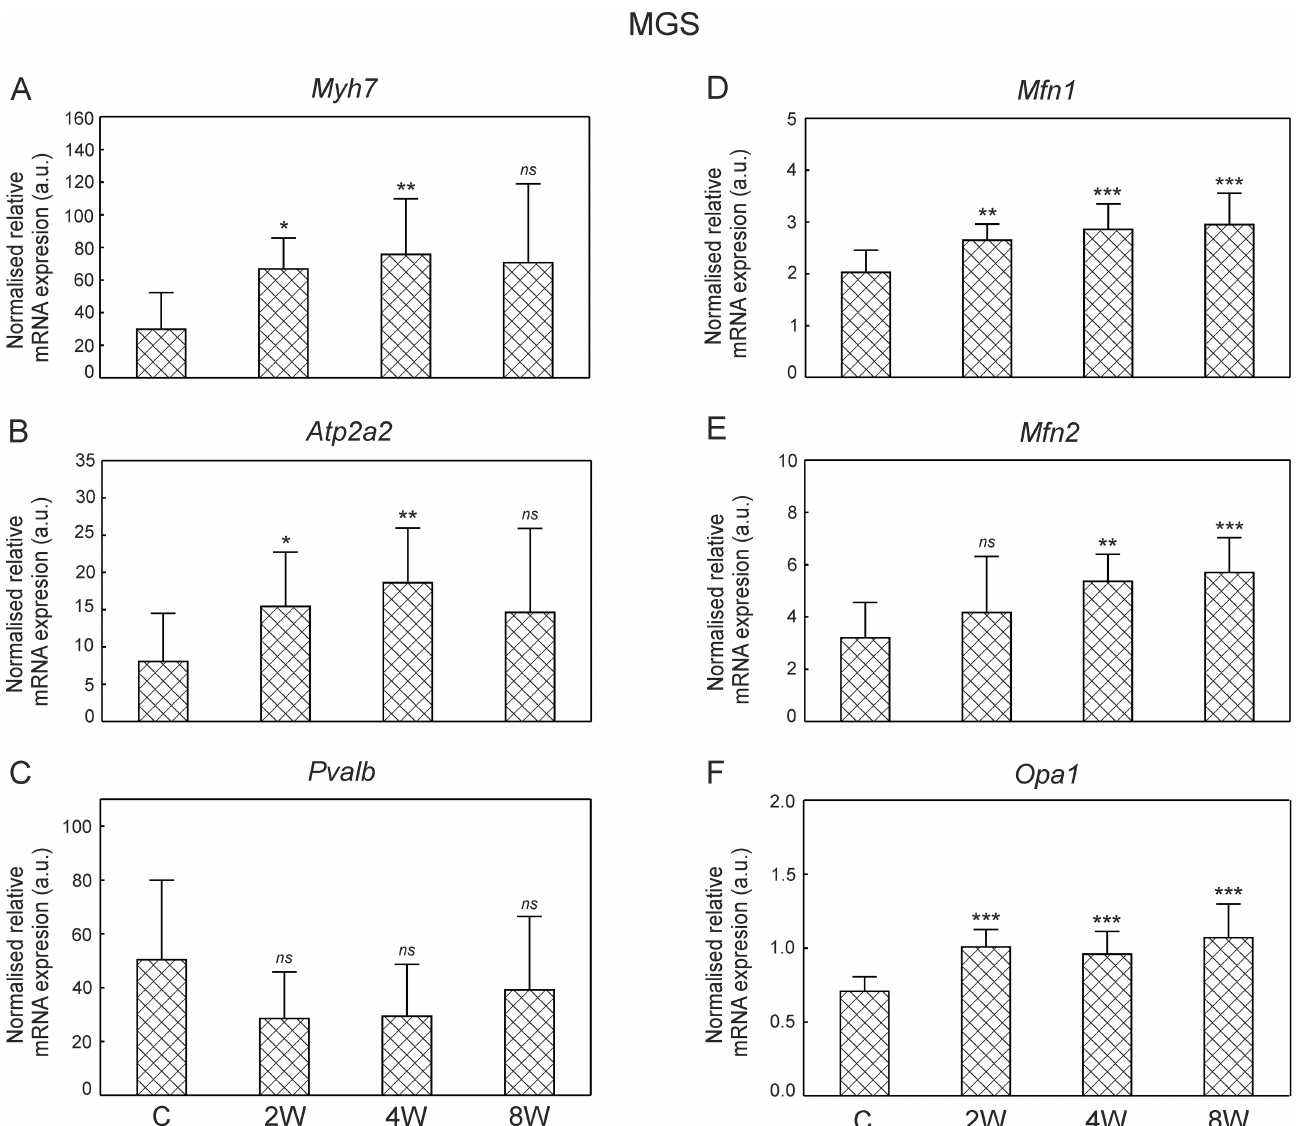
Fig 6. Relative mRNA expression levels in the MGS in control and trained animals. Relative mRNA expression of myosin heavy chain slow isoform ( Myh7 , panel A), SERCA2 ( Atp2a2 , panel B), parvalbumin ( Pvalb ,panel C), mitofusin 1 ( Mfn1 ,panel D), mitofusin 2 ( Mfn2 ,panel E), mitochondrial dynamin-like GTPase ( Opa1 ,panel F) in the slow part of the medial gastrocnemius (MGS) after 2, 4 and 8 weeks of endurance training. Data are presented as mean + SD normalized by the reference gene ( Hprt1 ). One-sided p-value represents the statistical significance of the training period (2, 4 or 8 weeks) with respect to the control group (Dunnett’s post hoc test) (S10 File). The symbols (cid:3) denote values significantly different: (cid:3) p < 0.05, (cid:3)(cid:3) p < 0.01, (cid:3)(cid:3)(cid:3) p < 0.001.